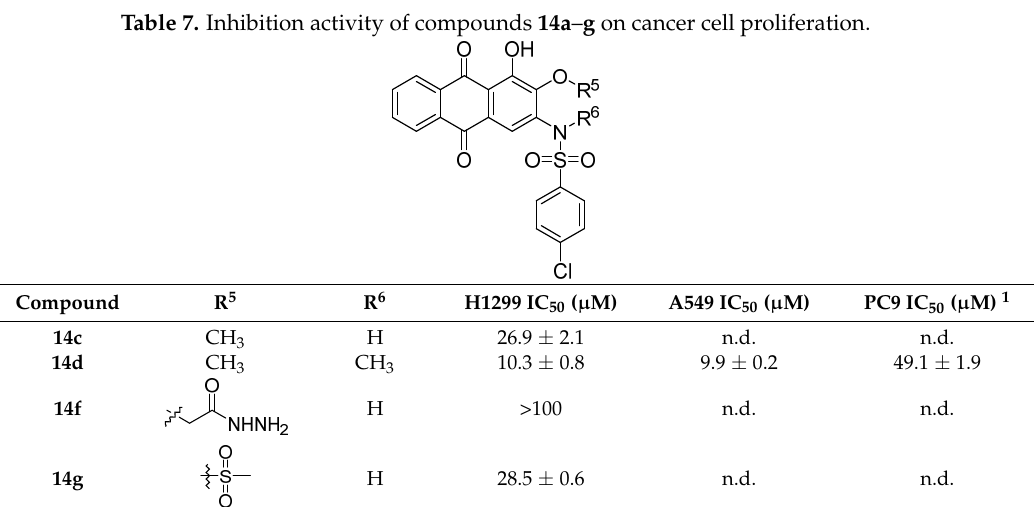
Table 4. The inhibition in the control linked enzyme assay of selected